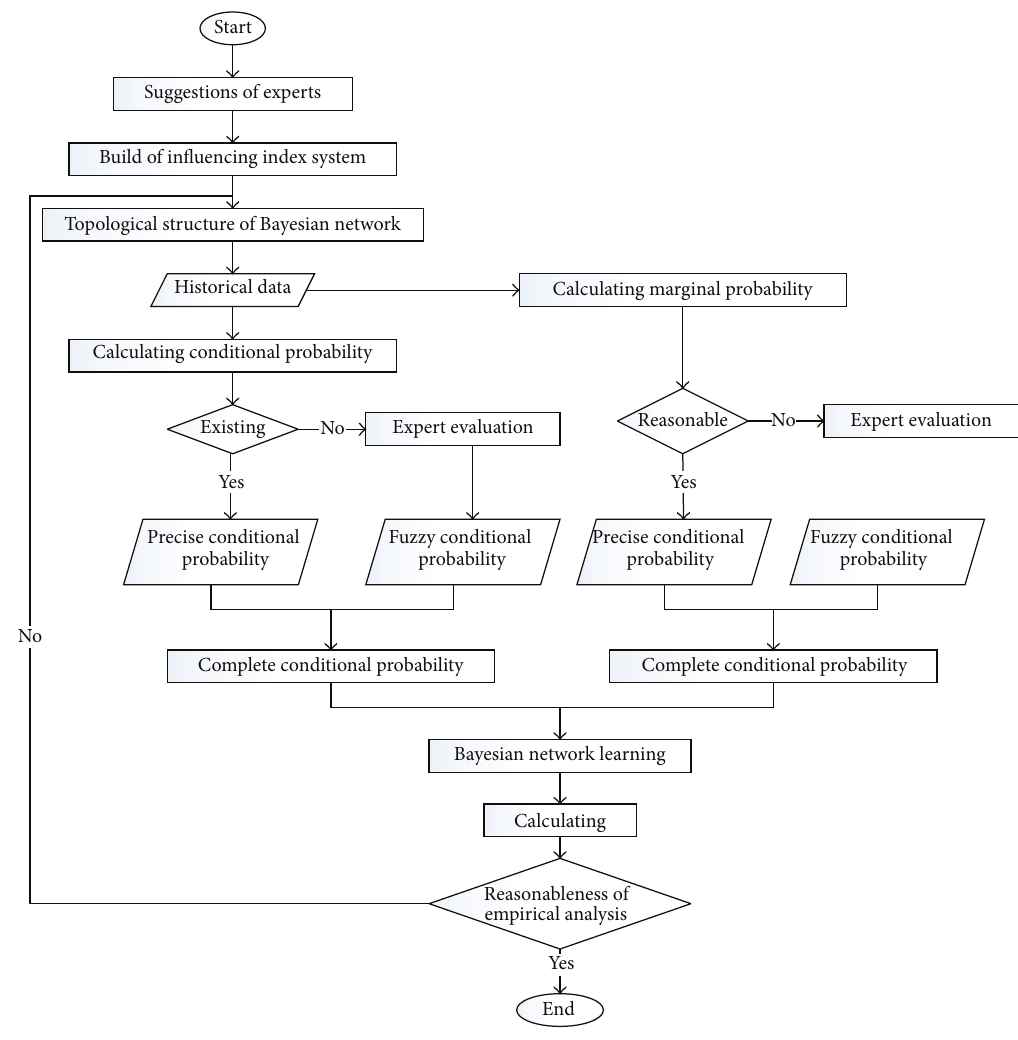
Figure 1: Topological graph of calculation process of the fuzzy-accurate Bayesian